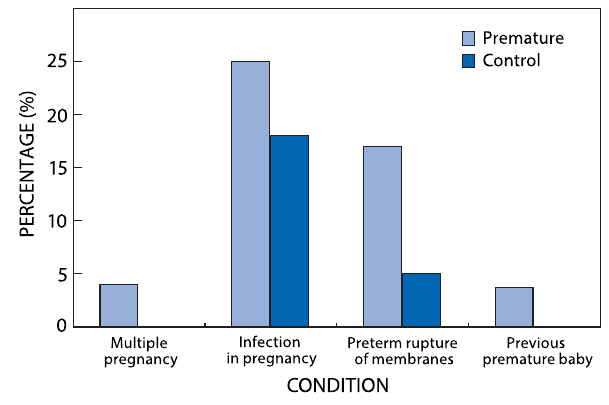
Figure 2: Conditions associated with premature